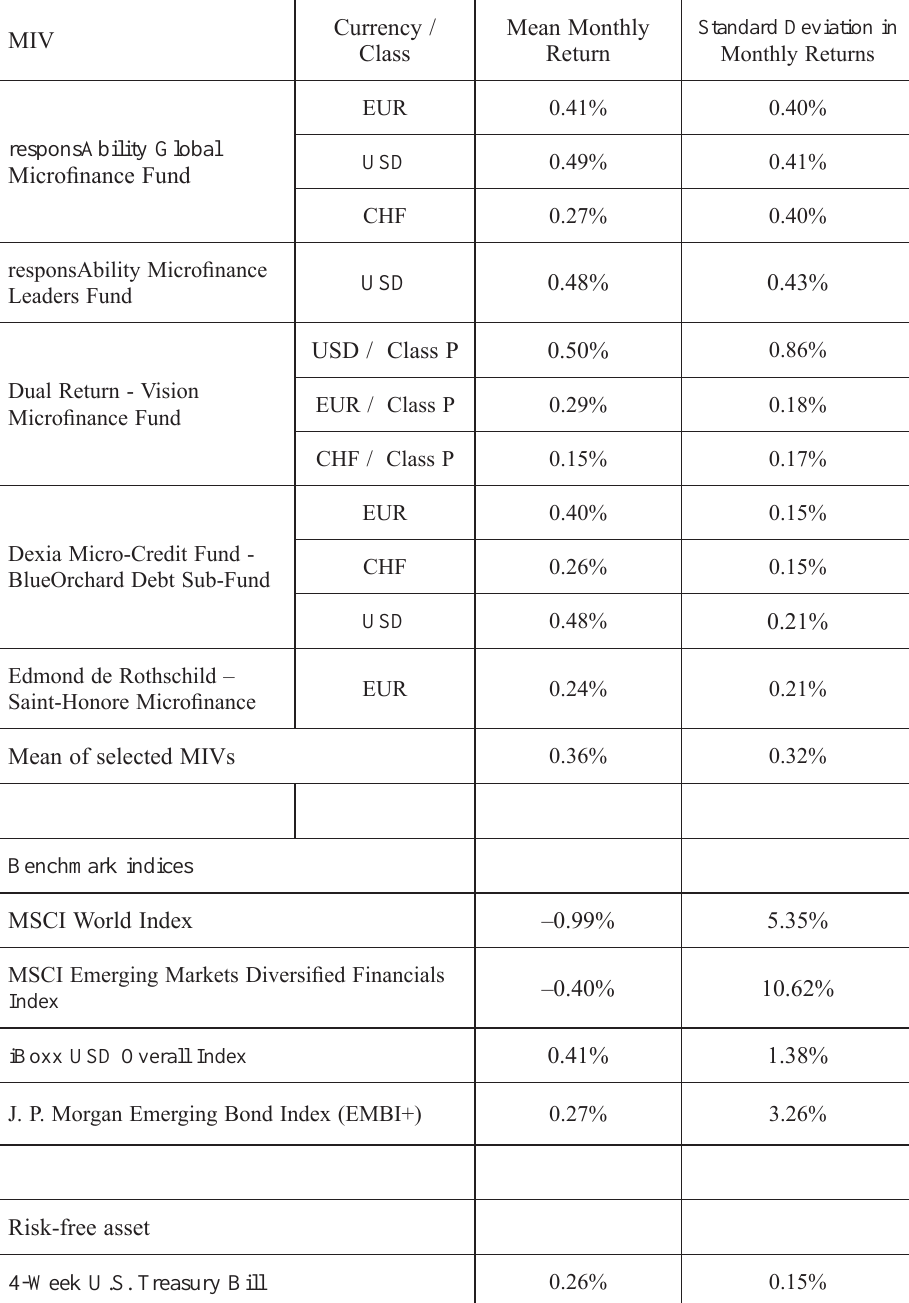
Table 3. Standard Deviation in Monthly